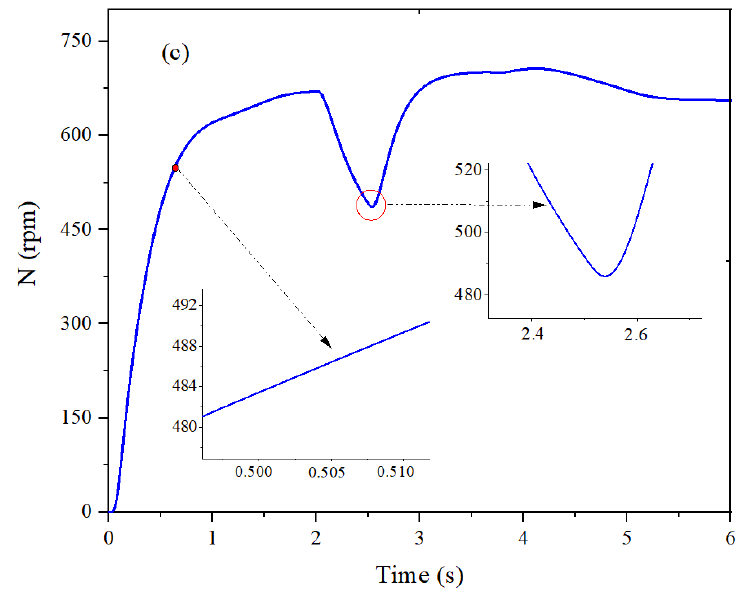
Figure 14. Simulation results associated with the M-INC technique. ( a ) Instantaneous power extracted from the GPV, ( b ) terminal voltage at the pump motor, ( c ) rotation speed of the pump motor.